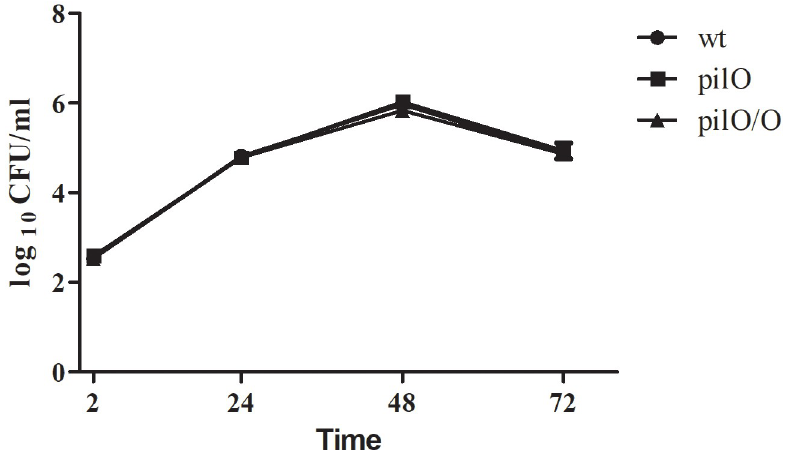
Fig 2. In vitro growth kinetics of the pilO mutant in BHI medium. Suspensions of 10 2 CFU/ml of the pilO mutant, the wt F . novicida and the complemented strain were prepared in BHI medium and bacterial numbers were followed during a period of 72 h. Statistical significance was determined by Student t- test ( � , p < 0.05).